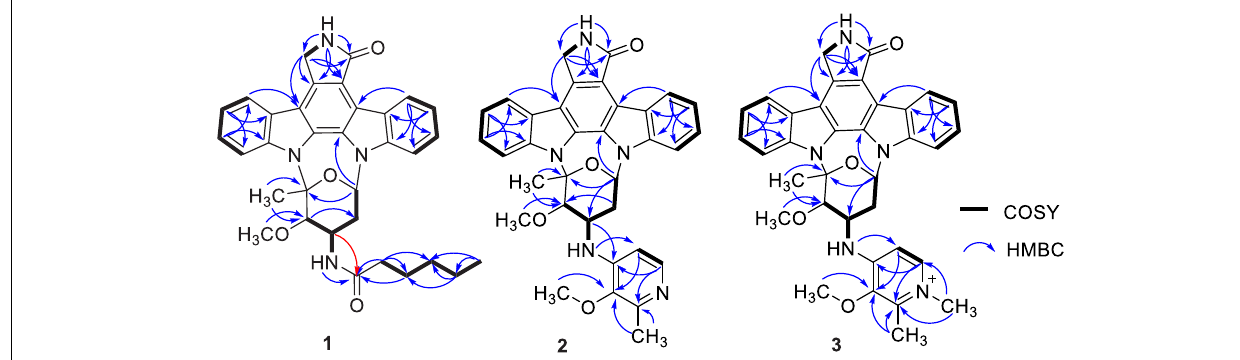
FIGURE 2 | 1 H- 1 H COSY and HMBC correlations of compounds 1 – 3 .